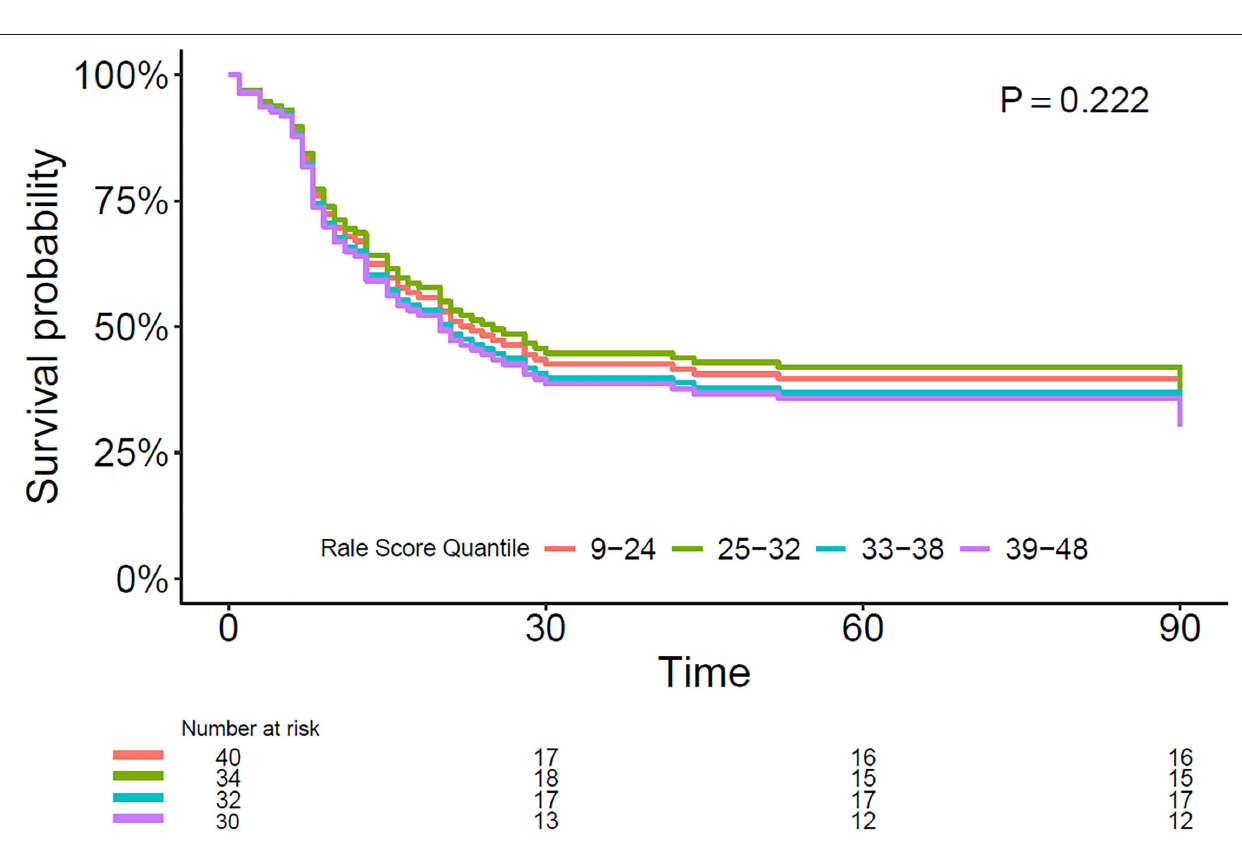
FIGURE 2 | Multivariable Cox model with survival estimates during the 90-day follow-up period in patients stratified by baseline RALE score quartiles. RALE, radiographic assessment for lung